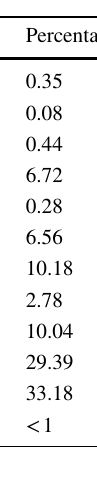
Table 3 XRF of shale for chemical analysis